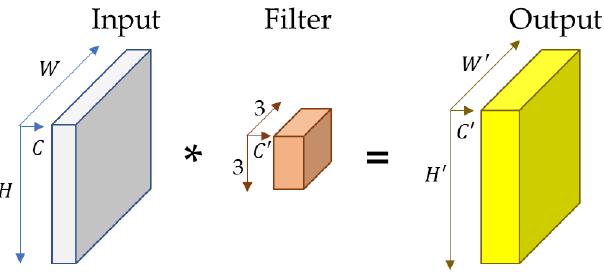
Figure 2. Traditional convolution operation with kernel size of 3 × 3 × 𝐶 ′ , where 𝐶 ′ indicates the output dimension of the feature maps.